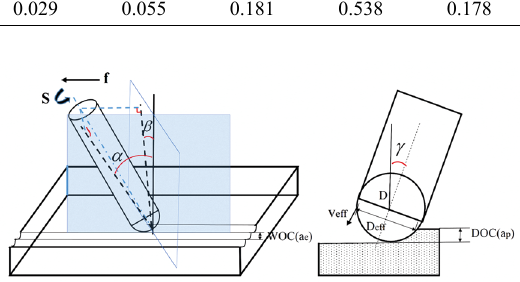
: Depth of cut, a : Width of cut, Figure 1. Ball end milling ( a p e f : Federate, S: Rotational Speed, α : Lead angle, β :Tilt angle, γ : inclination angle of tool axis, D: Tool diameter, D : Effective tool eff diameter, V ensure the consistency of depth below machined surface among the residual stress profiles. Moreover, the electrolyte was replaced for each cutting condition to eliminate the effect of electrolyte dilution. For each layer, residual stresses were measured in two directions: perpendicular (YY direction) and parallel to feed (XX direction), respectively.